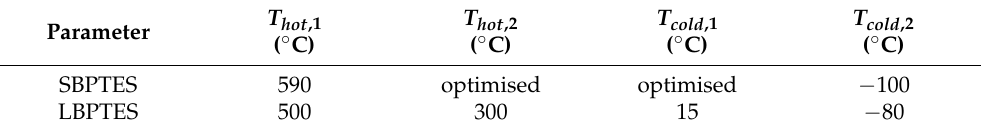
Table 2. Hot and cold reservoir operating temperatures. Data from